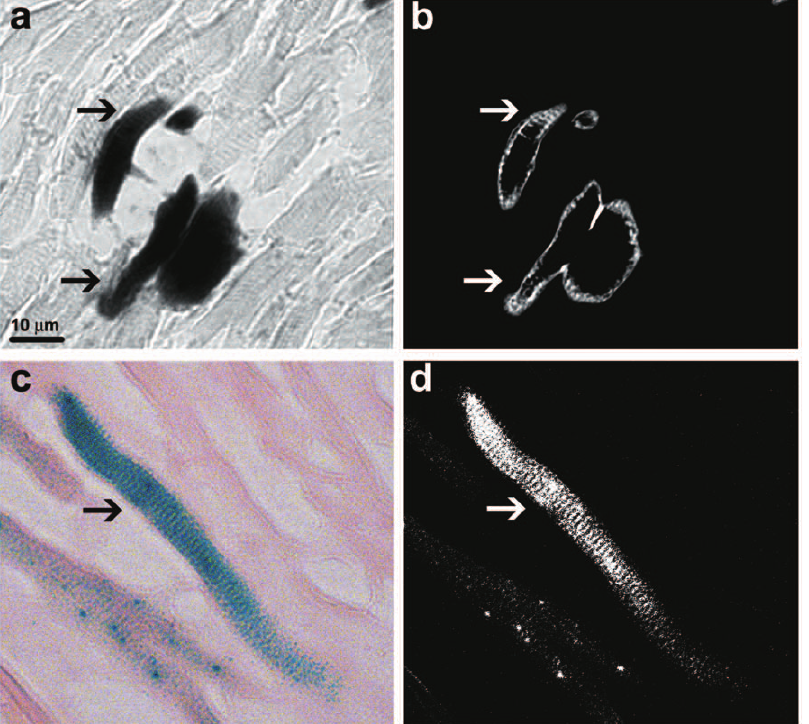
Figure 5. High-magnification phase-contrast and light microscopy images of XGAL-stained cells in the LV free wall from an adult mouse heart. (a) Black and white phase-contrast image of XGAL-stained myocytes (arrows). (b) Color light microscopy image of an XGAL-stained myocyte (arrow). Inverse images of (a) and (b) are shown in panels (c) and (d), respectively. Note the characteristic striated rectangular-like shape of the stained cells.